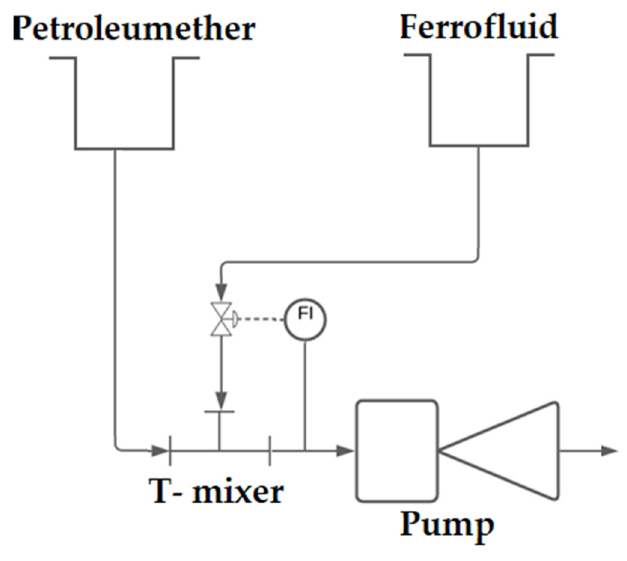
Figure 8. Continuity validity setup for the Phase controller—magnetic pump setup.